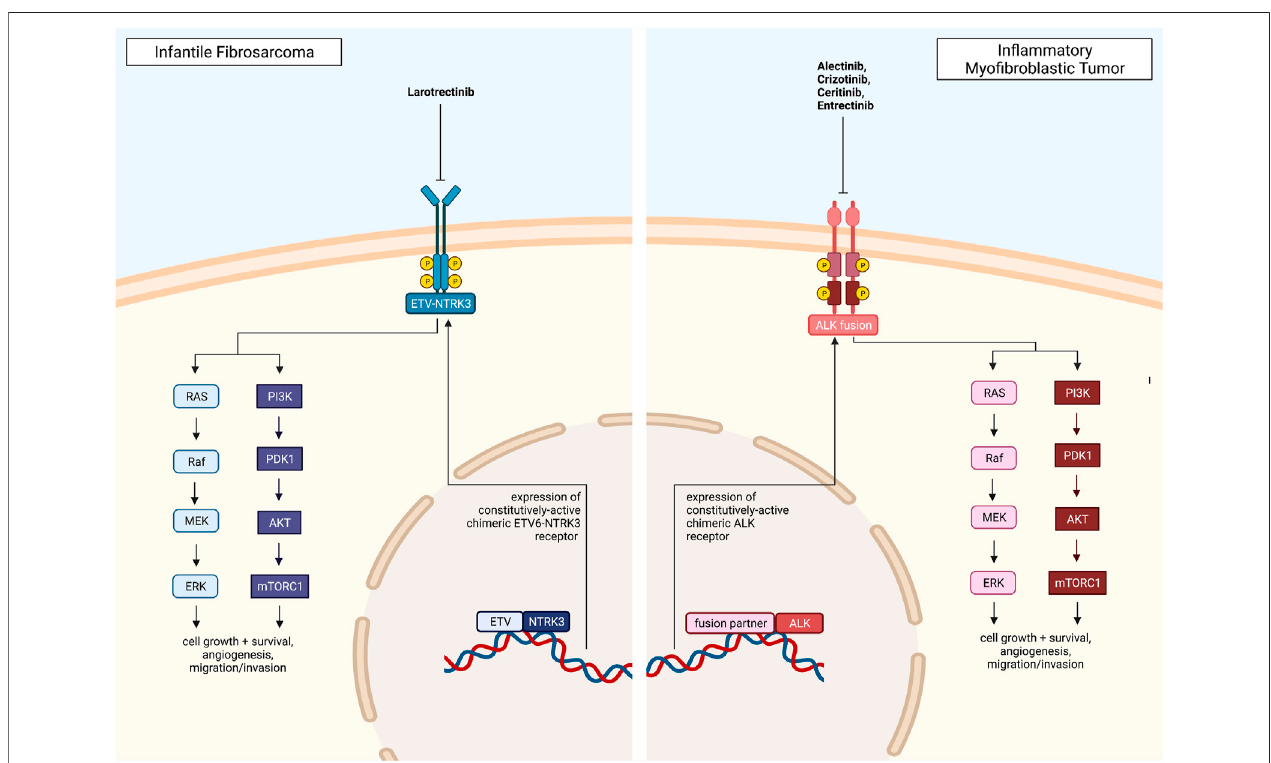
FIGURE 3 | Pediatric solid tumors with a direct, targetable fusion kinase, including Infantile Fibrosarcoma and In fl ammatory Myo fi broblastic Tumor, and clinically approved drugs. All fi gures were created with BioRender.com.